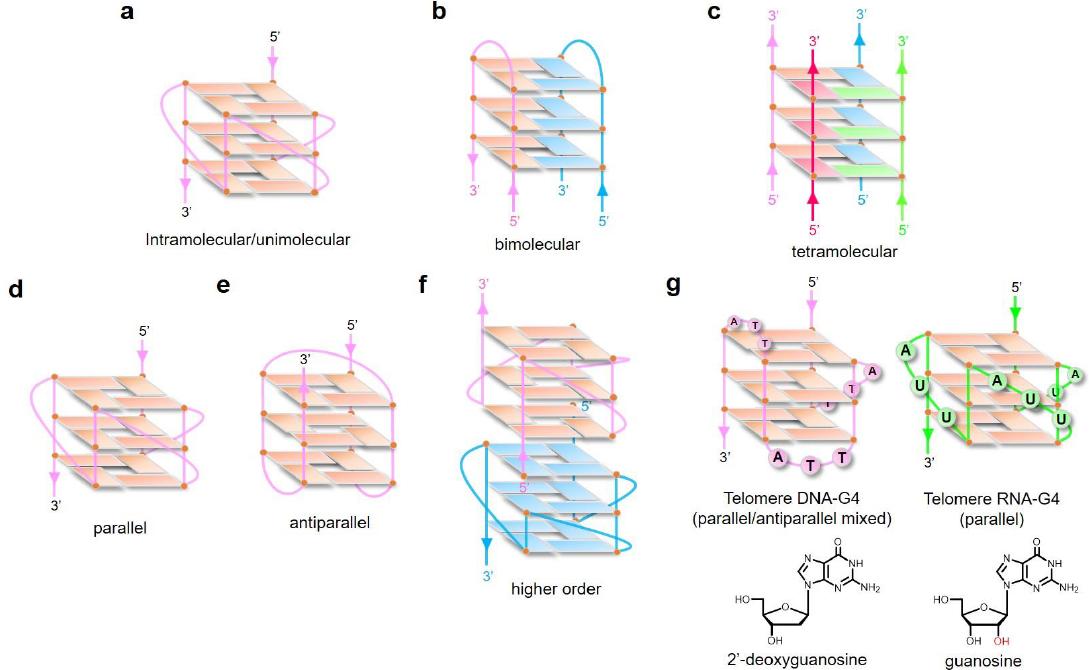
Figure 2. The topological variety of G-quadruplex structures. Schematic illustration of intramolecular/unimolecular ( a ), bimolecular ( b ), tetramolecular ( c ), parallel ( d ), antiparallel ( e ), and higher-order ( f ) G-quadruplexes. ( g ) Schematic illustration of telomere DNA-G4 (left) and RNA-G4 (right) in a potassium-containing solution. DNA-G4 is arranged in three G-quartet layers composed of 2 ′ -deoxyguanosines and three TTA loops, while RNA-G4 is arranged in three G-quartet layers composed of guanosines and three UUA loops. The 2 (cid:48) -hydroxyl group is highlighted in red for clarity.